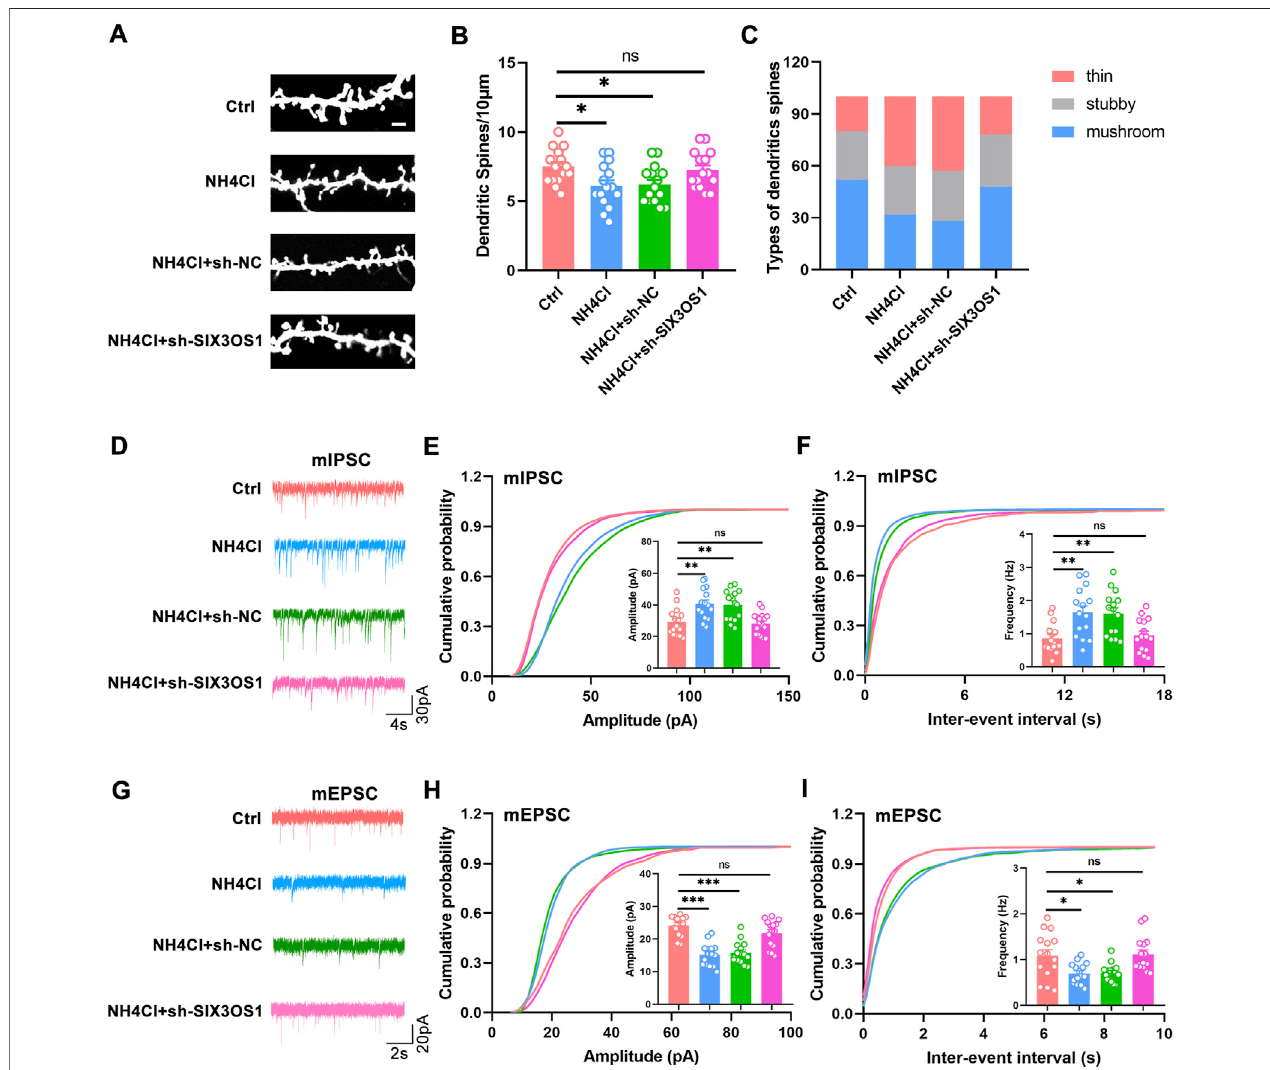
FIGURE 9 | SIX3OS1 silencing improved dendritic spines ’ maturity and synaptic function. (A) Representative immuno fl uorescence staining confocal images of dendrites of hippocampal neurons. Scale bar, 2 μ m. (B) Dendritic spine density of NH 4 Cl-treated hippocampal neurons was reduced compared with control group. DendriticspinedensityofNH 4 Cl+sh-SIX3OS1groupneuronswassimilartothatofcontrolgroup. n =15neuronspergroup.one-wayANOVAfollowedbyTukey ’ spost- hoctest. (C) Mushroom-shapeddendriticspinesofNH 4 Cl-treatedhippocampalneuronswasreducedcomparedwithcontrolgroup.Mushroom-shapeddendritic spines of NH 4 Cl + sh-SIX3OS1 group neurons was similar to that of control group. n = 15 neurons per group. (D) Representative mIPSC traces. (E) Increased mIPSC amplitude of hippocampal neurons in NH 4 Cl-treated. Reduced mIPSC amplitude of hippocampal neurons in NH 4 Cl-sh-SIX3OS1 treated. (F) Increased mIPSC frequency of hippocampal neurons in NH 4 Cl-treated. Reduced mIPSC frequency of hippocampal neurons in NH 4 Cl-sh-SIX3OS1 treated. (G) Representative mEPSC traces. (H) ReducedmEPSCamplitudeofhippocampalneuronsinNH 4 Cl-treated.IncreasedmEPSCamplitudeofhippocampalneuronsinNH 4 Cl-sh-SIX3OS1treated. (I) Reduced mEPSC frequency of hippocampal neurons in NH 4 Cl-treated. Increased mEPSC frequency of hippocampal neurons in NH 4 Cl-sh-SIX3OS1 treated. n = 15 neurons per group. one-way ANOVA followed by Tukey ’ s post-hoc test. Data were shown as mean ± SEM. * p < 0.05, ** p < 0.01, *** p < 0.001; ns, no signi fi cant